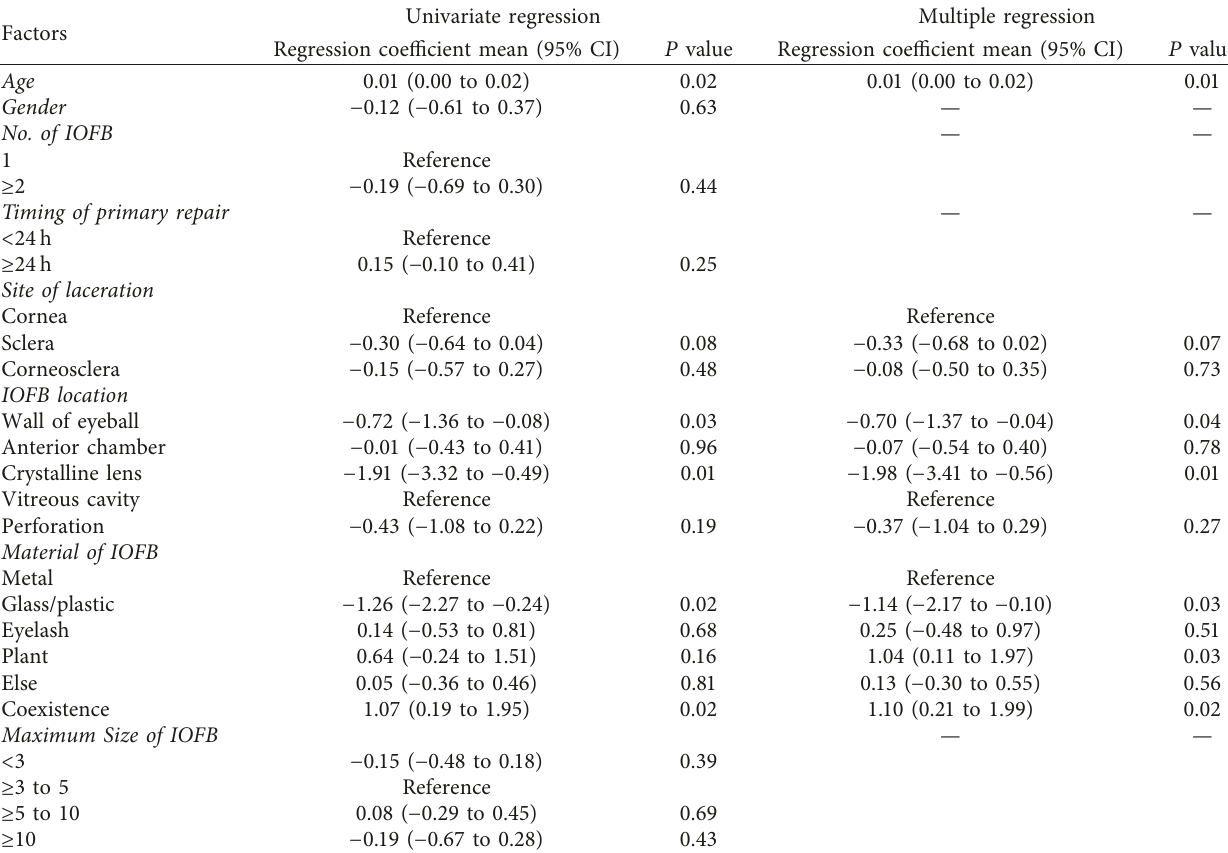
Table 3: Associations between intraocular foreign body characteristics and endophthalmitis by logistic